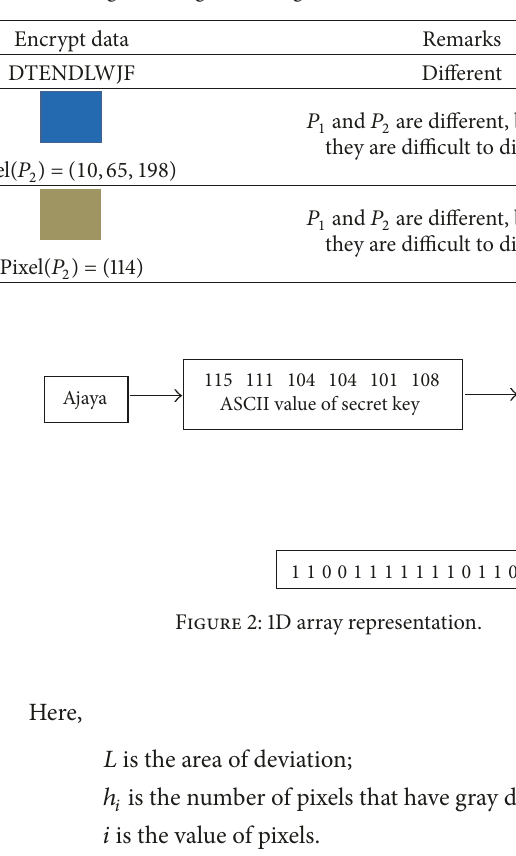
Table 1: The difference between text encoding and image encoding.